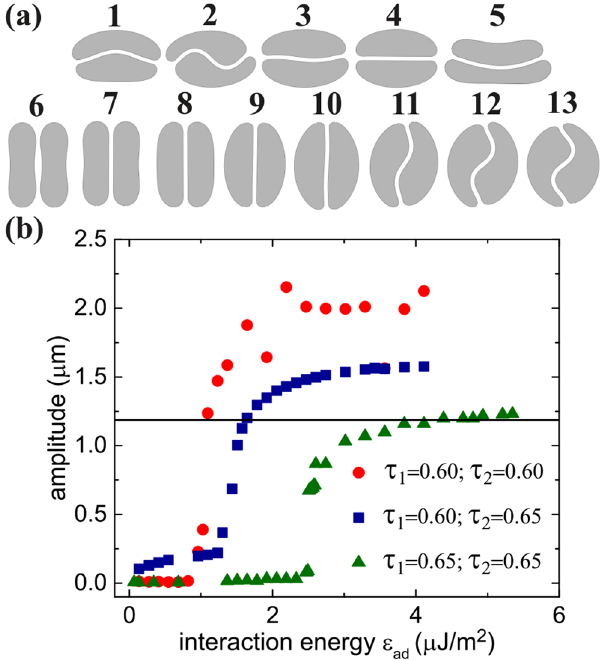
Figure 4. ( a ) 2D simulation of vesicles doublets. (1–5) for the same interaction energy ε ad = 1.16 μ J/m 2 and using different combinations of reduced areas: (1) τ 1 = 0.50 and τ 2 = 0.65; (2) τ 1 = τ 2 = 0.60; (3) τ 1 = 0.60 and τ 2 = 0.65; and (4) τ 1 = τ 2 = 0.65, one identifies male-female shape (1), S-shape (2,3), and flat contact interface (4). (5) a parachute shape aggregate observed when considering the membrane stiffness as a variable; the used parameters read as τ 1 = 0.55 and τ 2 = 0.40, κ B 1 = κ B 2 = κ B /4, and ε ad = 0.025 μ J/m 2 . (6–13): 2D simulation of doublets for different interaction energies: from (6) to (13) ε ad = 0, 0.07, 0.34, 1.37, 2.47, 2.54, 3.02, 5.21, 8.23 μ J/m 2 . The reduced area of both cells is fixed to τ 1 = τ 2 = 0.65. ( b ) The amplitude of deformation of the contact zone between the doublets as function of the interaction energy for different combinations of reduced